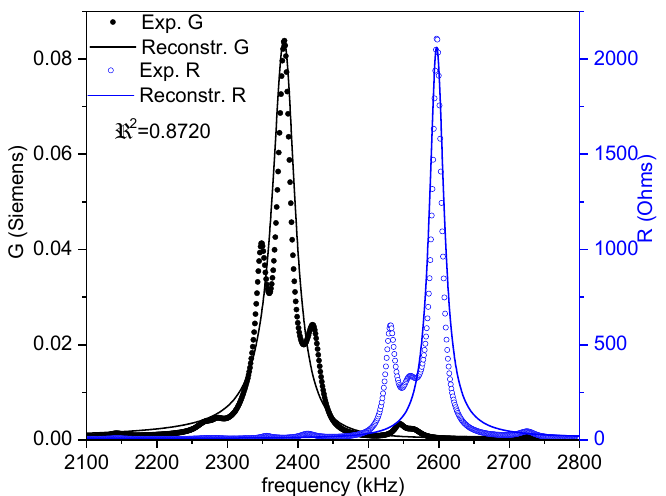
Figure 3. Fundamental thickness extensional resonance mode of a thin disk. The impedance spectra in an ( R , G ) plot of a disk with a 12 mm diameter and 1.00 mm thickness. The symbols are the experimental data, and the lines are the reconstructed peaks after the calculation of the coefficients. The value of the regression factor for this calculation ( ℜ 2 ) is shown. The black symbols and lines ( G data) can be read in the left-y-axis, and the blue ones ( R data) are in the right-y-axis.